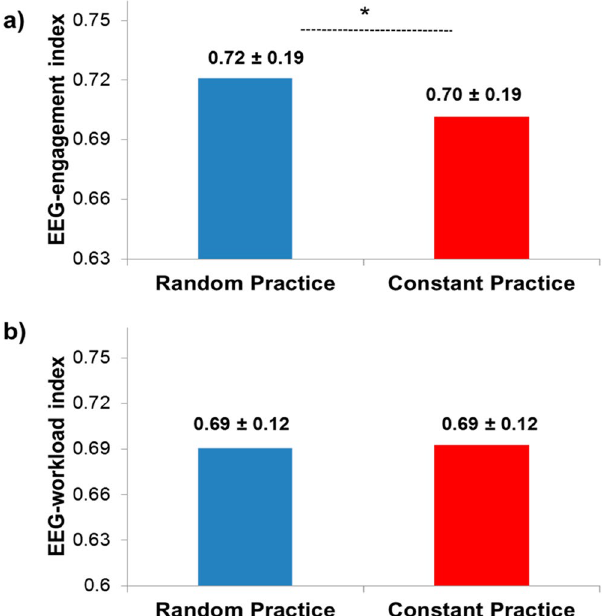
Figure 3. Means of the ( a) EEG-engagement index and ( b ) EEG-workload index in the random and constant practice conditions (*represents significant